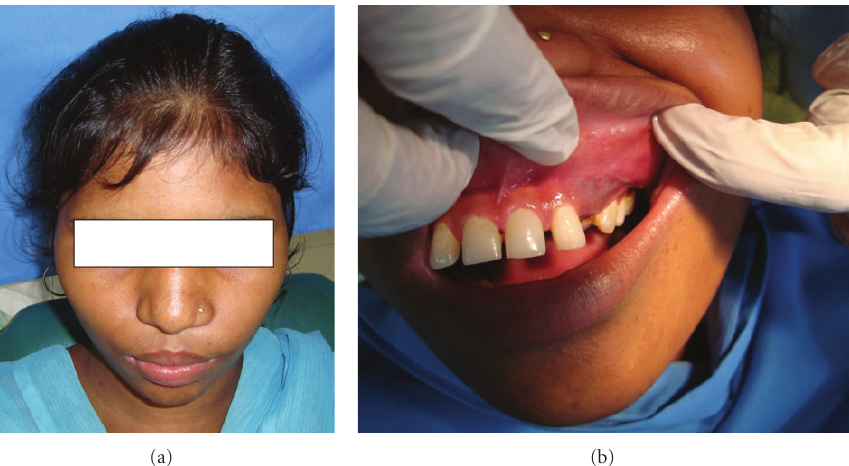
Figure 1: (a) Preoperative extraoral photograph of 15-year-old female with swelling on left maxilla. (b) Preoperative intraoral photograph showing missing canine tooth.